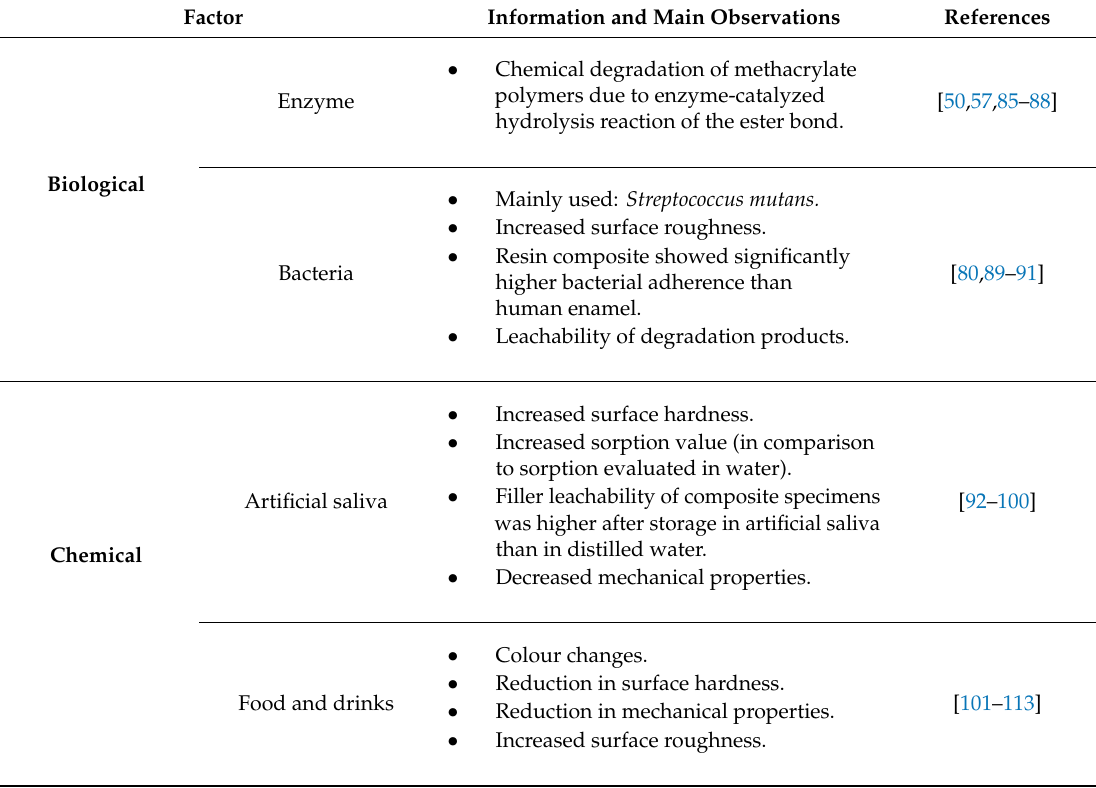
Table 1. Relevant studies assessing the impact of di ff erent factors on dental composites.